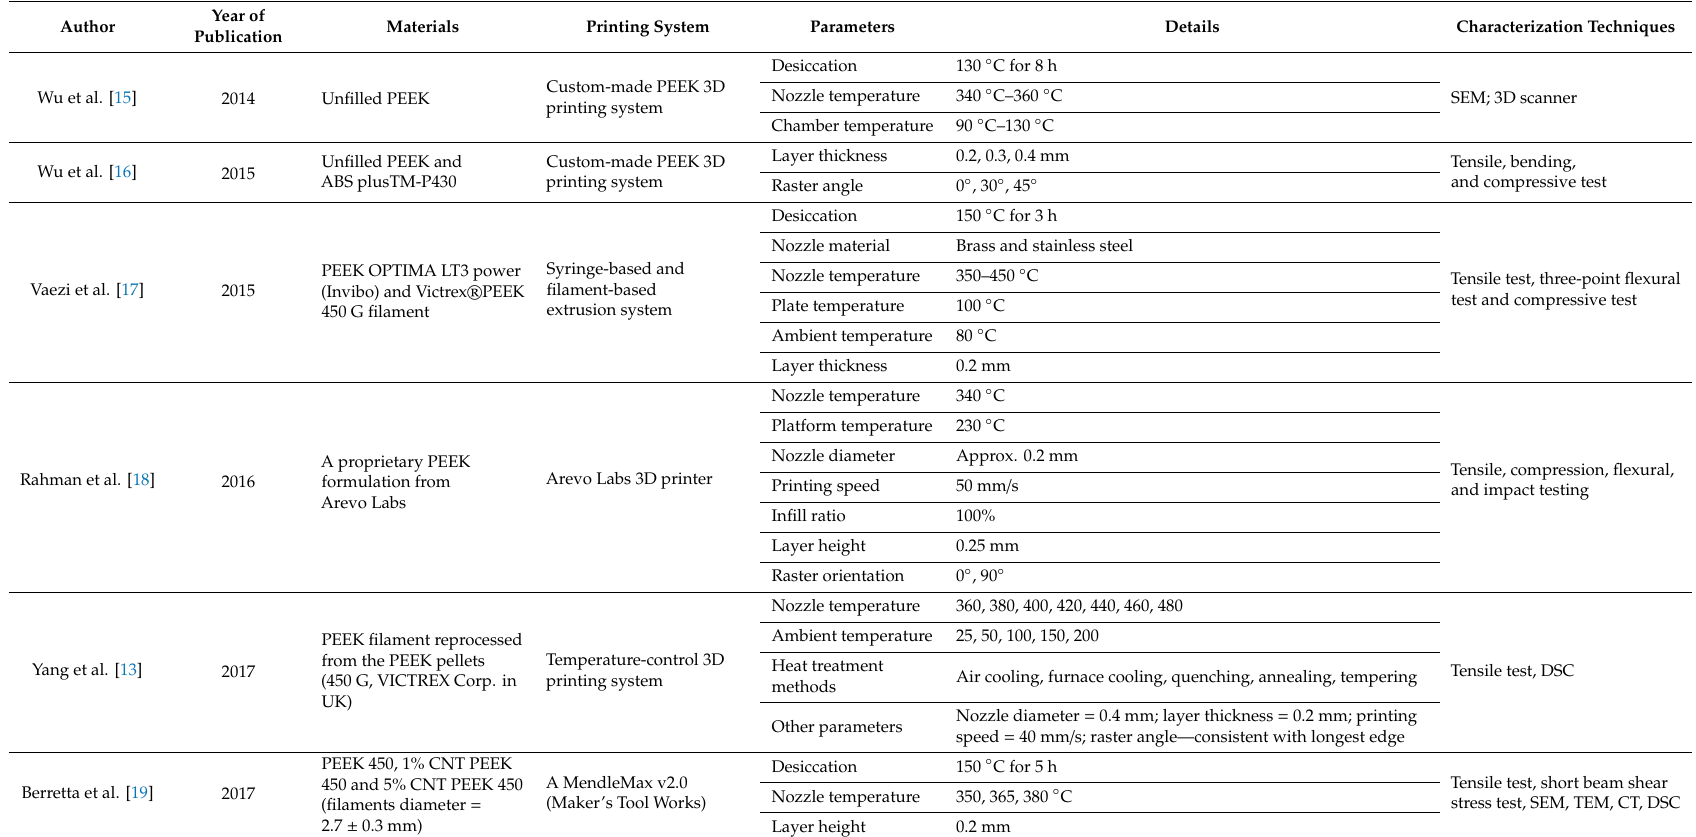
Table 1. Summary of articles discussing printing parameters and